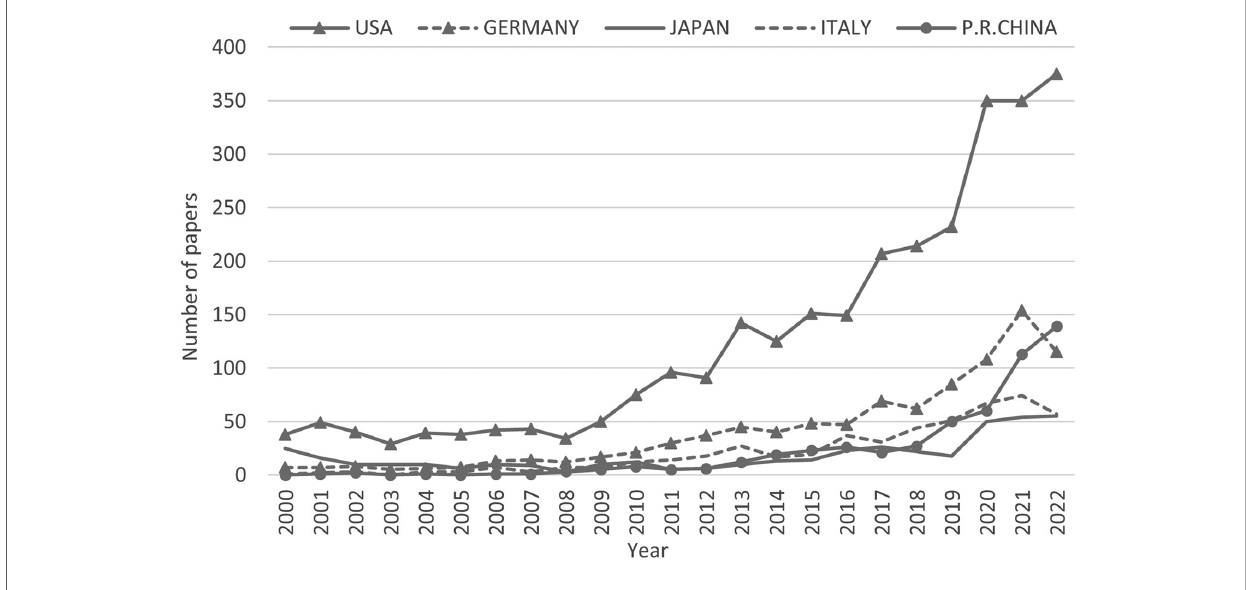
FIGURE 4 Trend of ECMO research papers published in selected countries/regions since 2000.